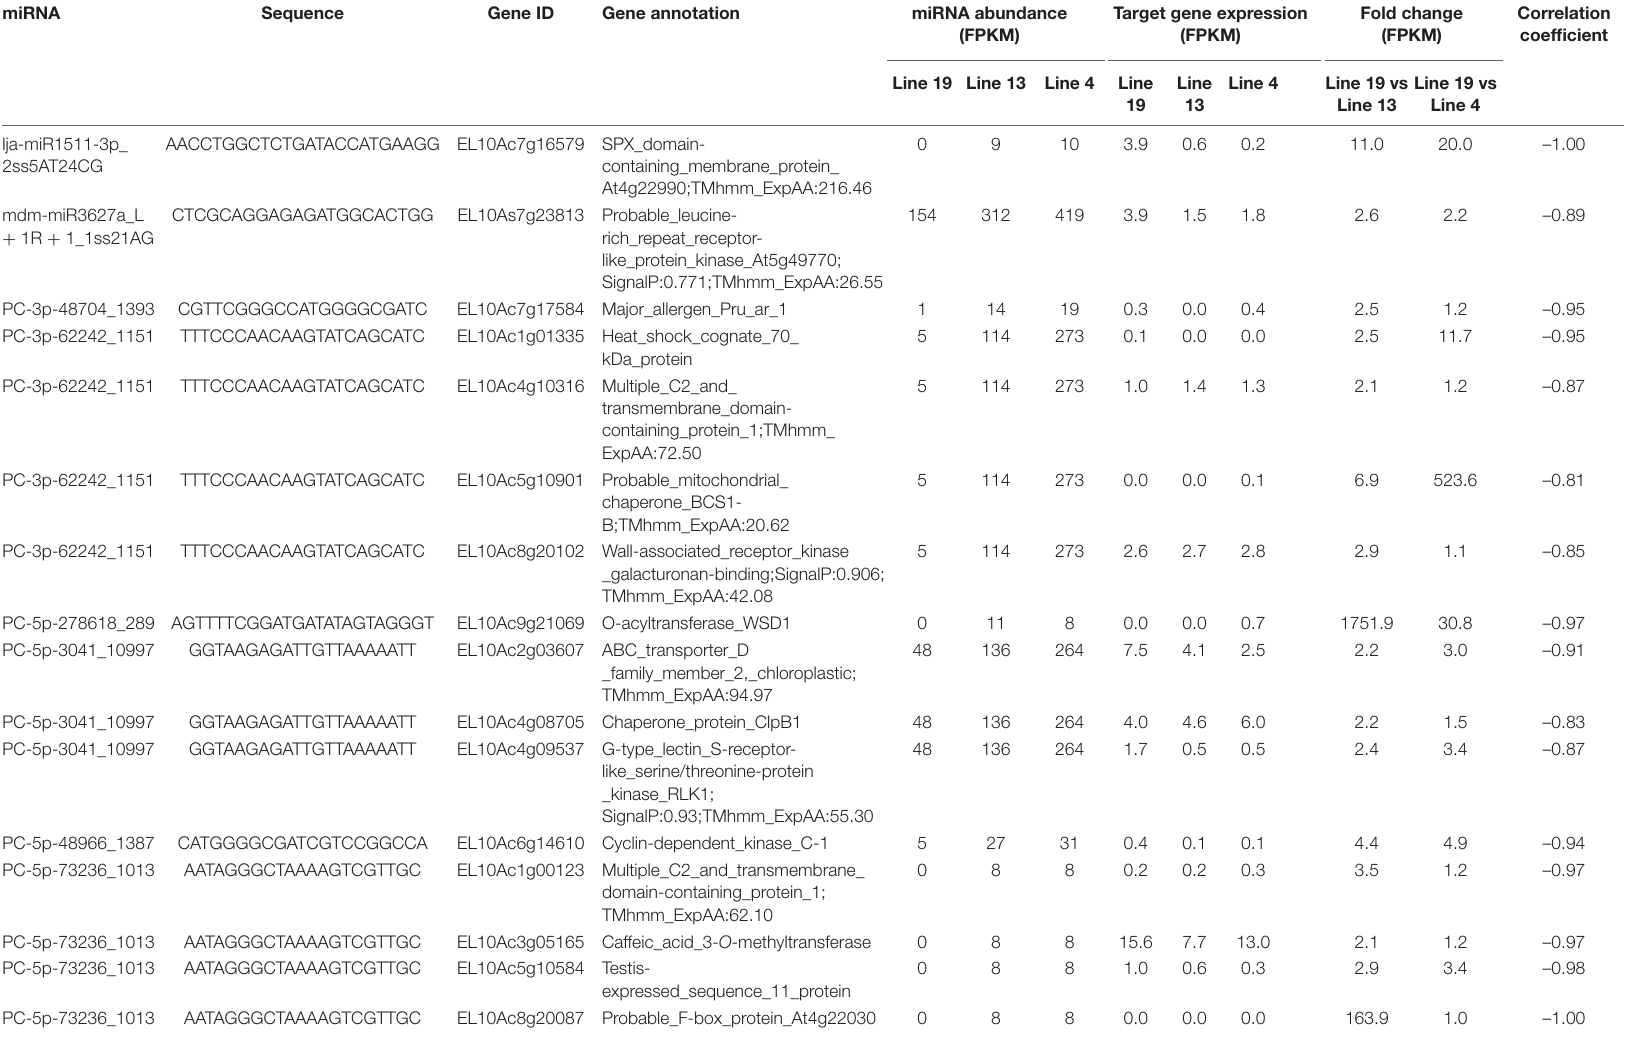
TABLE 1 | Sugar beet miRNAs that showed > 2-fold expression in the apical leaves of BCTV resistant (13, 4) vs. susceptible (19) lines at 2 dpi and effect on corresponding sugar beet target gene expression.